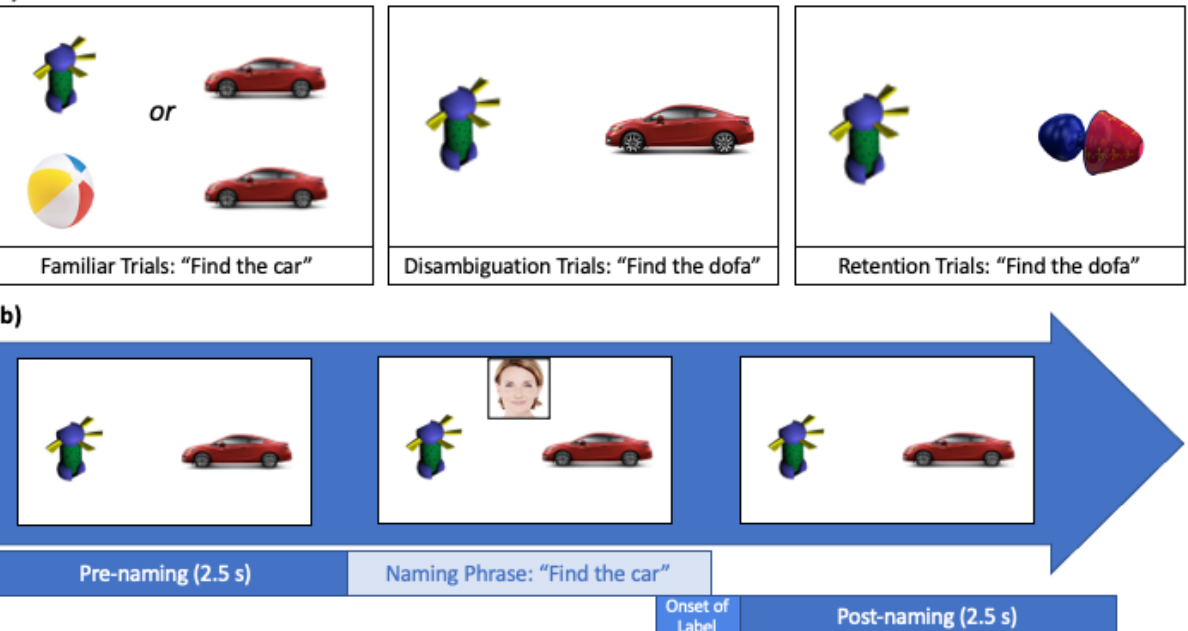
Figure 1. ( a ) Top row displays examples of the familiar, disambiguation, and retention trials. Note that these are not the stimuli as they appeared in the study. ( b ) Bottom row displays the time course of each trial, in which there was a pre-naming period (2.5 s), followed by the naming phrase, followed by the post-naming period (2.5 s).